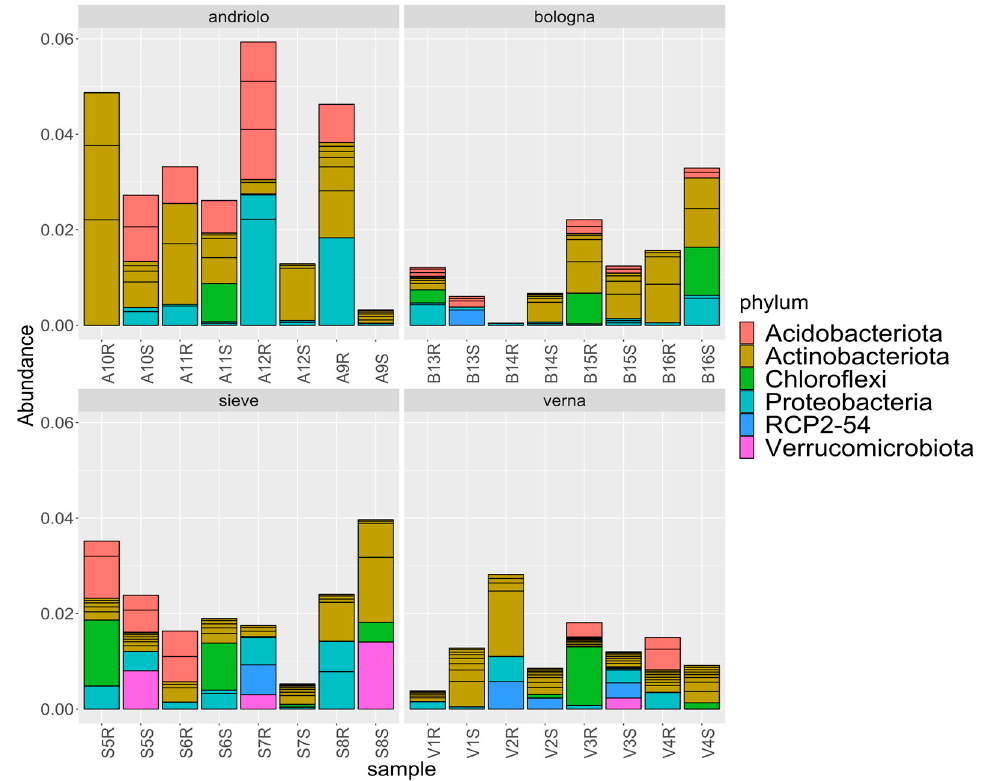
Figure 4. Relative abundances of taxonomies. Abundances of the top twenty detected ASVs are reported at phylum level in relation to variety.